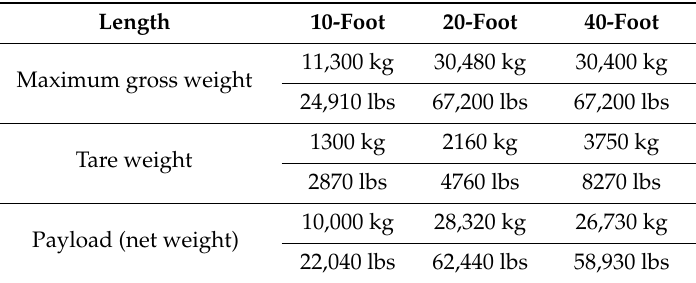
Table 1. Typical weights of some standard shipping containers.